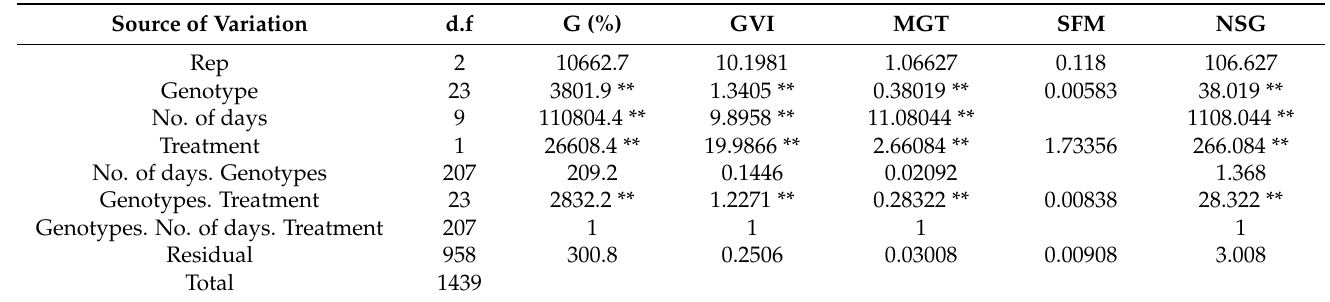
Table 1. An analysis of 24 Bambara groundnut genotypes under controlled and simulated drought conditions. The mean square of the germination percentage (G%), the germination velocity index (GVI), the mean germination time (MGT), seedling fresh mass (SMF), and the number of seeds germinated (NSG).